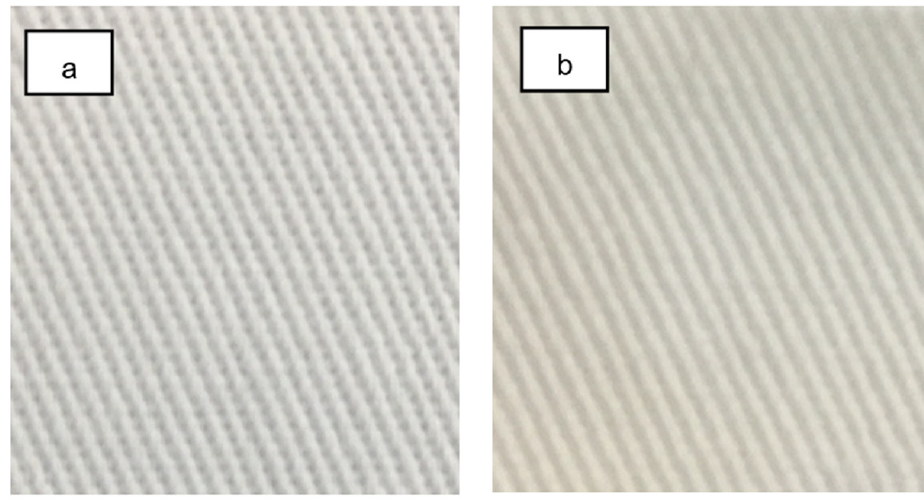
Figure 2. Image of the control ( a ) and functionalized ( b ) fabric with AgNPs-CMC nanocomposite.